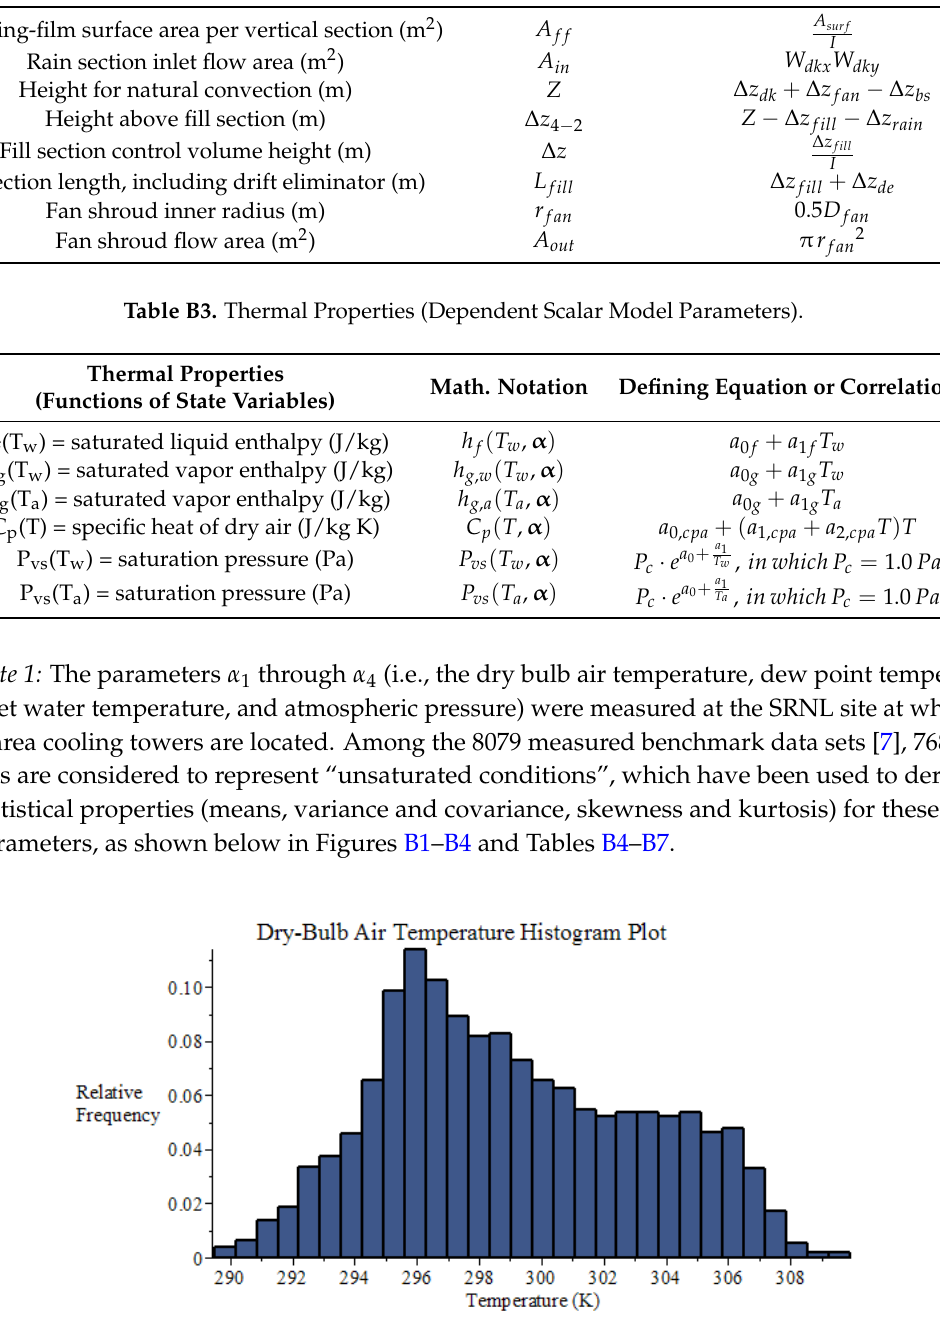
Figure B1. Histogram plot of dry-bulb air temperature data collected by SRNL from F-Area cooling towers (unsaturated conditions). Table B4. Statistics of the dry-bulb temperature (set to air inlet temperature) distribution [K].